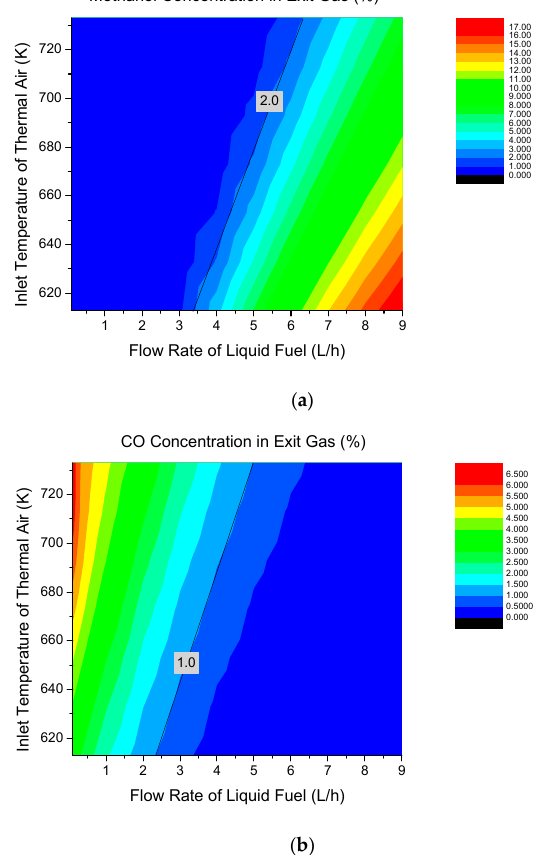
Figure 10. Profiles of ( a ) methanol concentration, and ( b ) CO concentration in the exit gas of reformer with different inlet flow rate of fuel mixture and inlet temperature of thermal air.